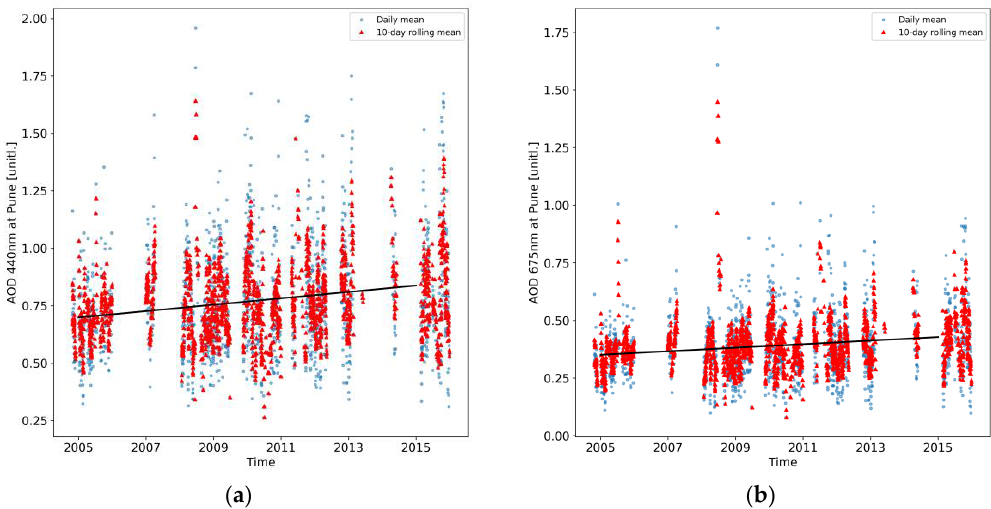
Figure 7. AERONET level 1.5 measurements of Aerosol Optical Depth (AOD) at Pune for: ( a ) 440 nm; and ( b ) 675 nm. Blue circles indicate daily means, red triangles 10-day rolling mean. Black line indicates linear trend for 2005–2015.